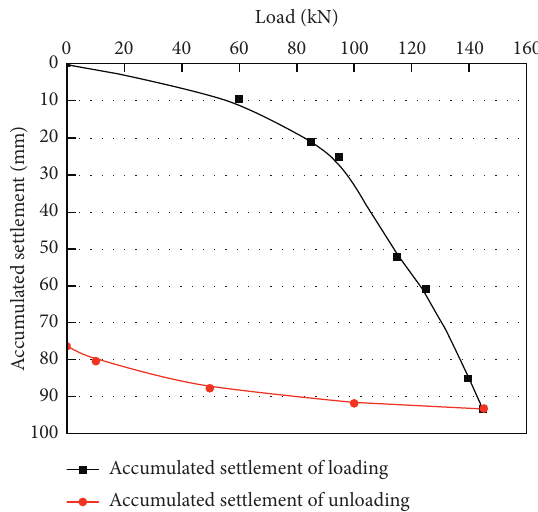
Figure 11: Accumulated settlement under vertical load for Test 1.